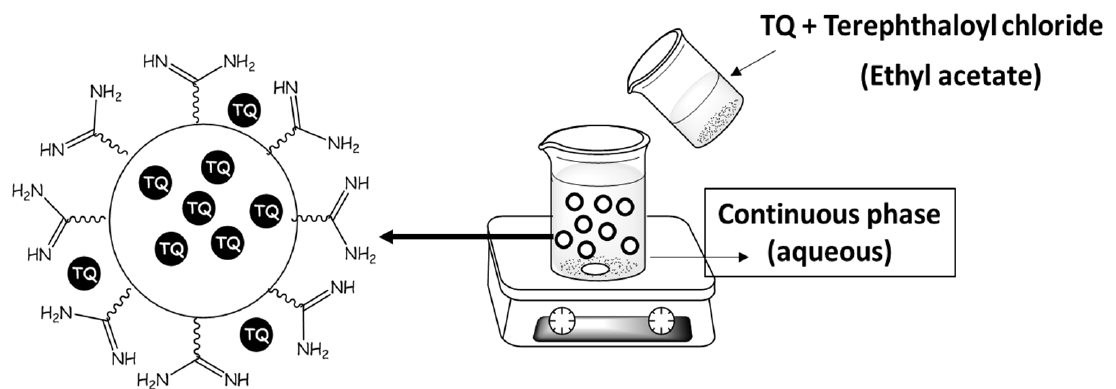
Figure 2. Schematic representation of interfacial polycondensation process and the formed TQ- loaded poly(ester amide) based on L-arginine, where part of the TQ is dispersed within the polymer and the other part is attracted to the surface of the polymer.